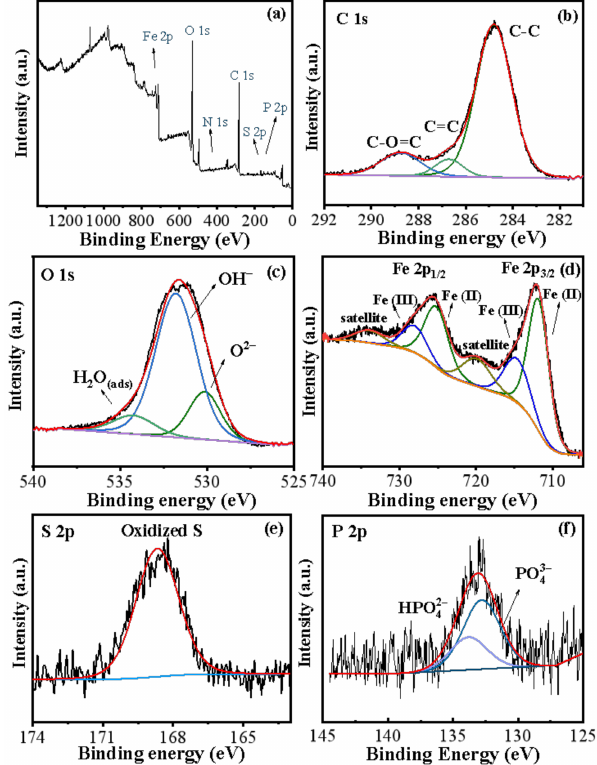
Figure 7. XPS spectra of the surface elements of the precipitate after treatment: ( a ) survey spectrum, ( b ) C element, ( c ) O element, ( d ) Fe element, ( e ) S element, and ( f ) P element. Conditions: initial pH = 2, applied voltage = 3 V, iron powder = 1.2 g/L, Na 2 SO 4 concentration = 0.025 mol/L. The black lines refer to the raw data of XPS while the colored lines refer to the deconvoluted